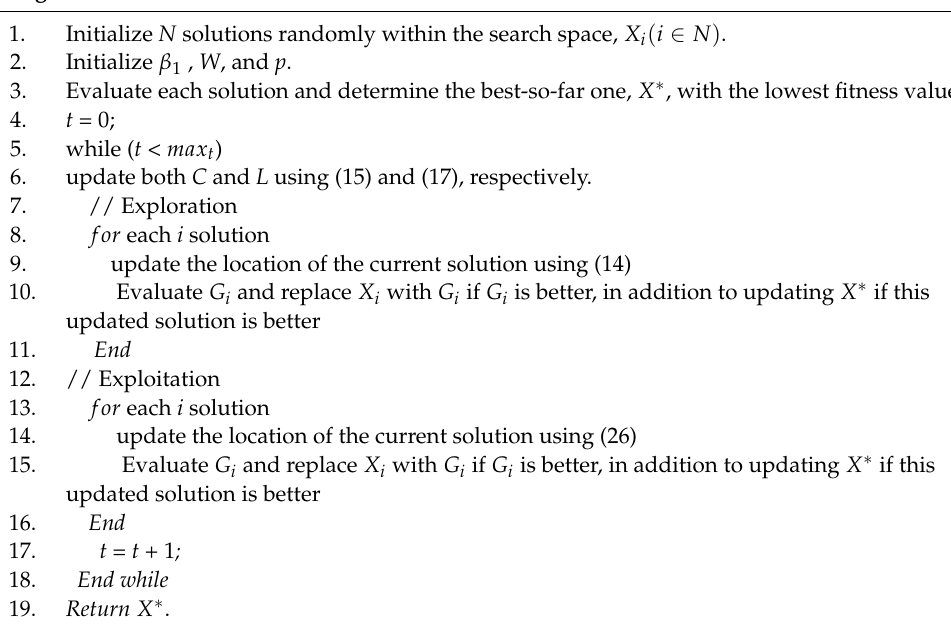
Algorithm 1 Pseudocode for